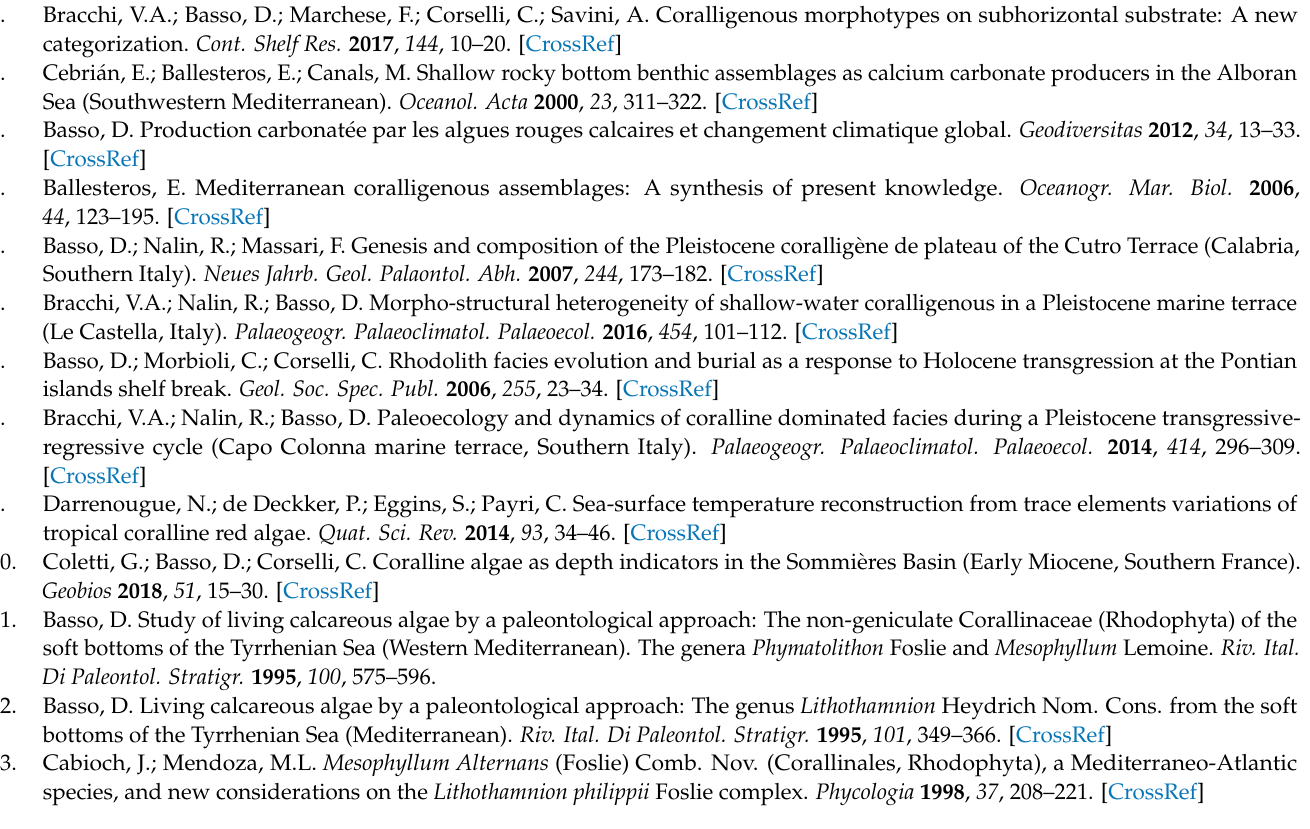
Figure A2. LIME, Saliency and Grad − CAM techniques show the pixels giving the major contributions to CNN classification: ( a ) magnification of the epithallial cell wall in Lithophyllum racemus evidence the significant contribution of calcification, formed by rod − shaped crystallites; ( b ) Mesophyllum philippii conceptacle shape focused by Saliency; ( c ) starch grains within the perithallial cells of L. racemus did not hamper correct identification; ( d ) the background beyond the epithallus of Lithothamnion corallioides was likely responsible for the erroneous classification of this image.